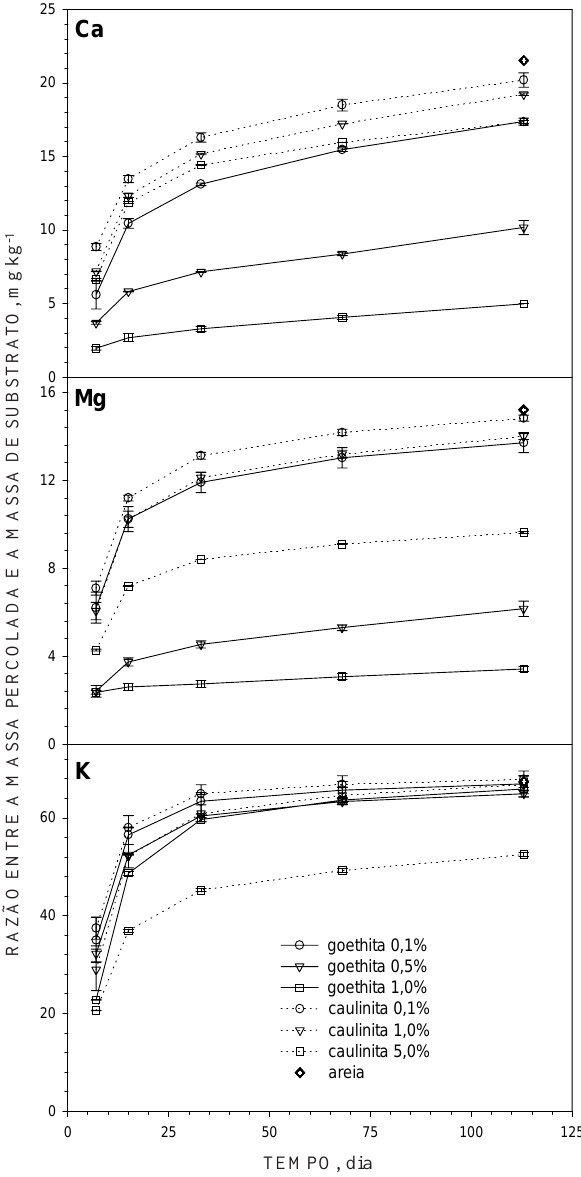
Figura 1. Razão entre as massas percoladas acumula- das de Ca, Mg e K e a massa de substrato com diferentes proporções de goethita sintética e caulinita natural, considerando o tempo de decomposição de palha de milho (as barras verticais representam o erro-padrão da